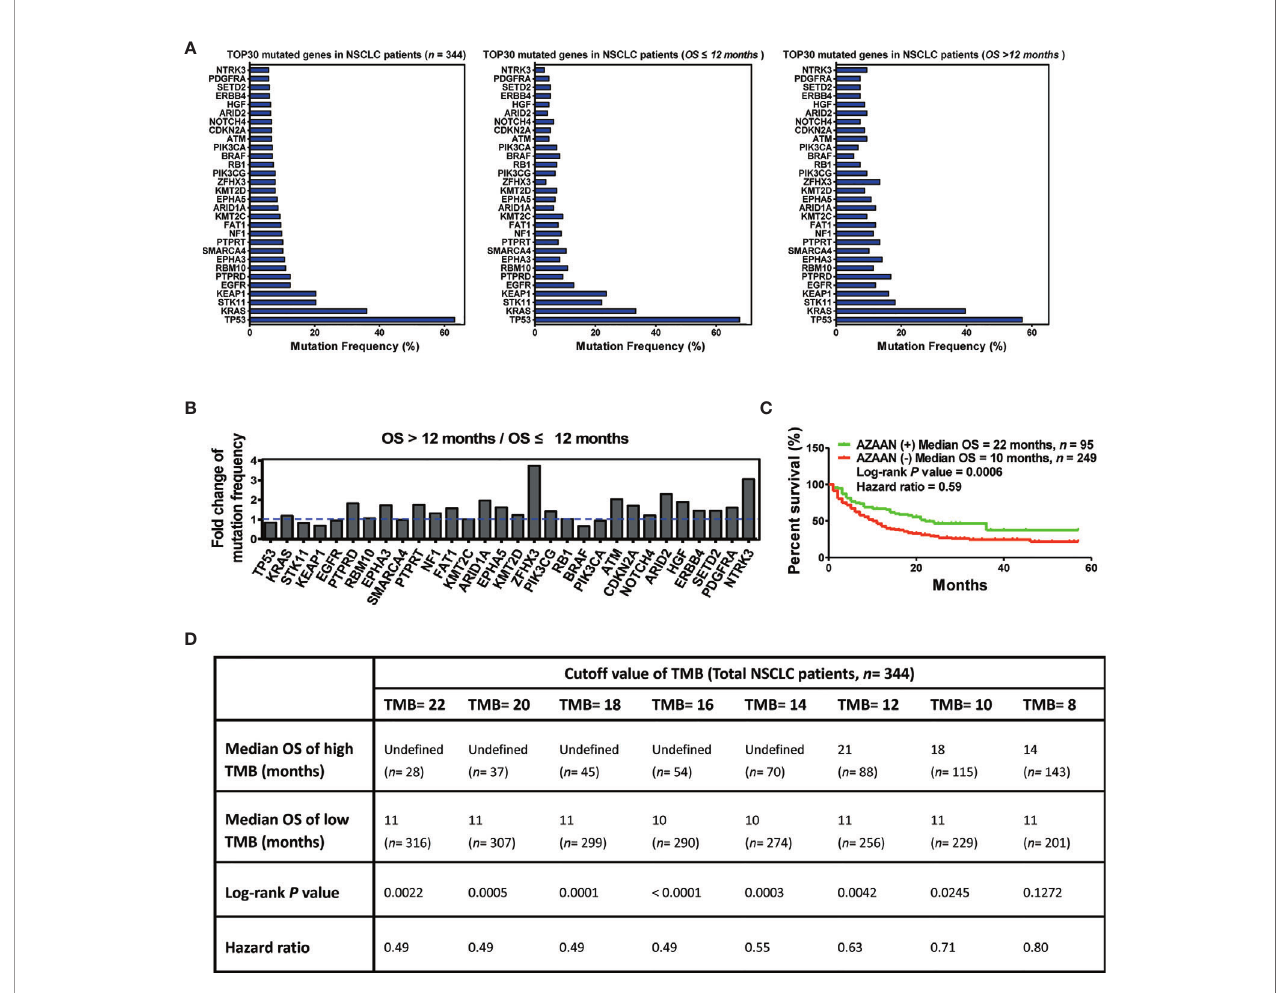
FIGURE 2 | AZAAN mutation status as a stratifying predictor of immunotherapy in NSCLC. (A) Left: Mutation frequency of the top 30 genes. Middle: Mutation frequency of the top 30 genes for patients with NSCLC having OS ≤ 12 months. Right: Mutation frequency of the top 30 genes for patients with NSCLC having OS >12 months. (B) Fold change in mutation frequency with OS >12 months/OS ≤ 12 months for the top 30 genes. (C) Kaplan – Meier curve analysis of OS strati fi cation using the AZAAN ( ARID1A , ZFHX3 , ATM , ARID2 , and NTRK3 ) mutation status. (D) Different TMB cutoffs used as a predictor for